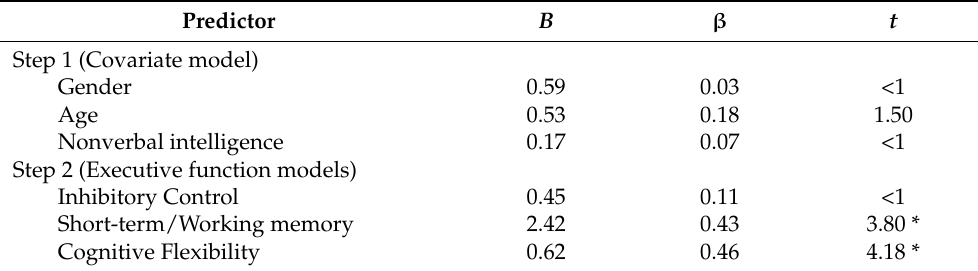
Table 2. Parameter estimates for regression models that predict language